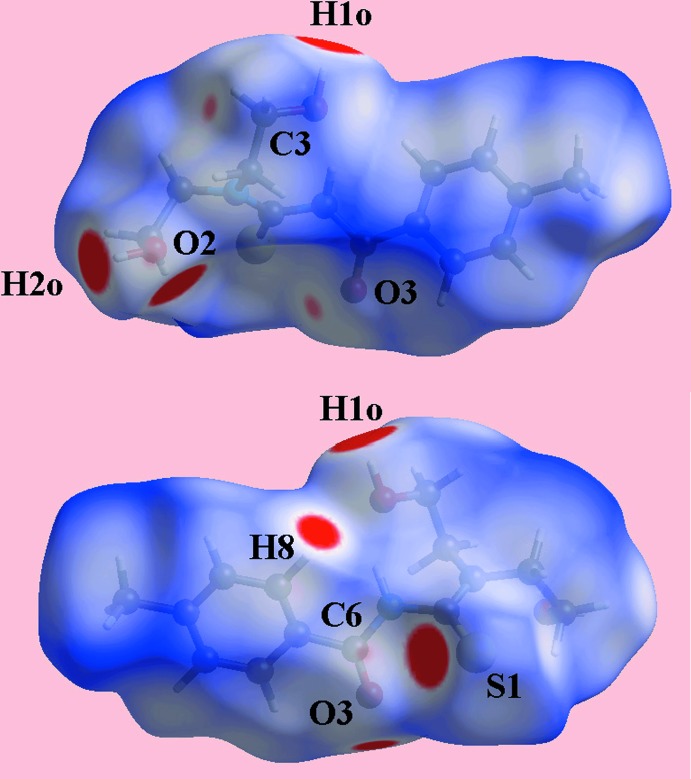
Two views of the Hirshfeld surface mapped over d
norm for (I) in the range −0.132 to +1.682 arbitrary units.